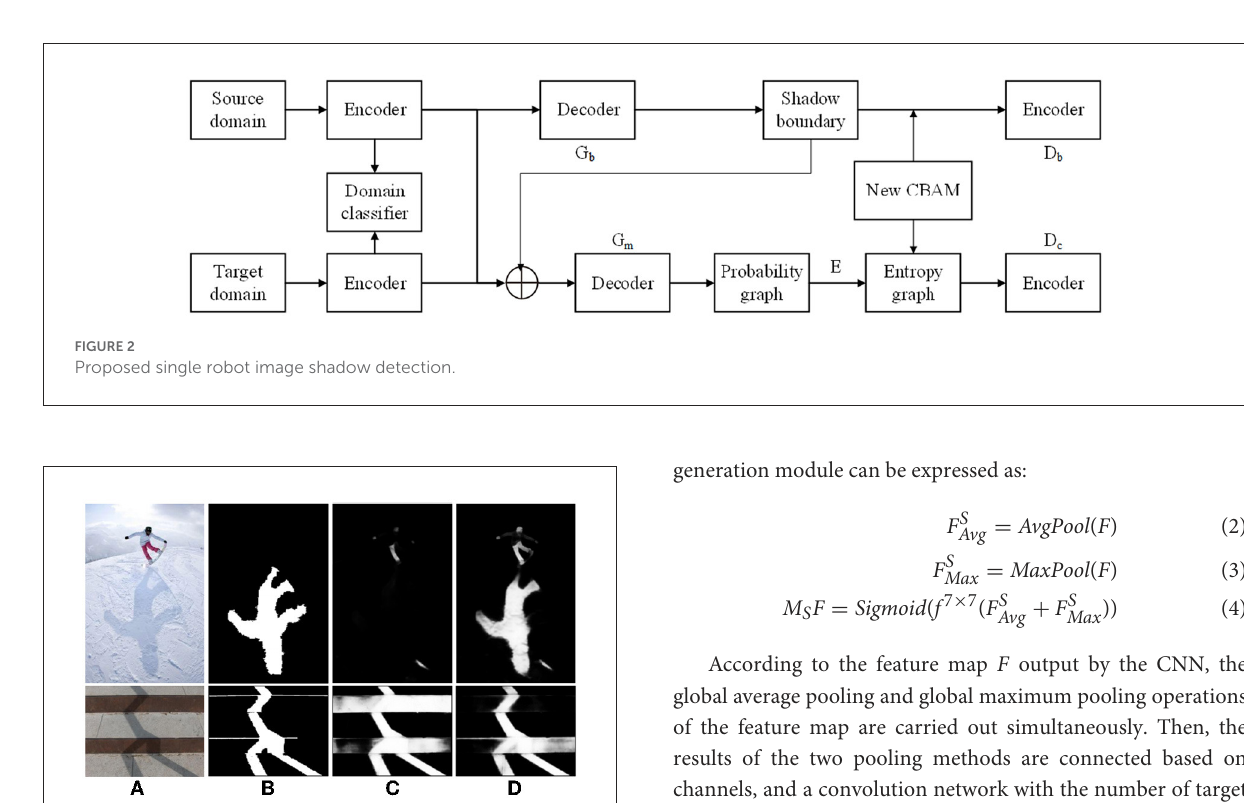
FIGURE3 Effect of hierarchical domain adaptation on shadow detection. First column (A) , second column (B) , third column (C) , and fourth column (D) are shadow image, GT, global domain adaptation, hierarchical domain adaptation,